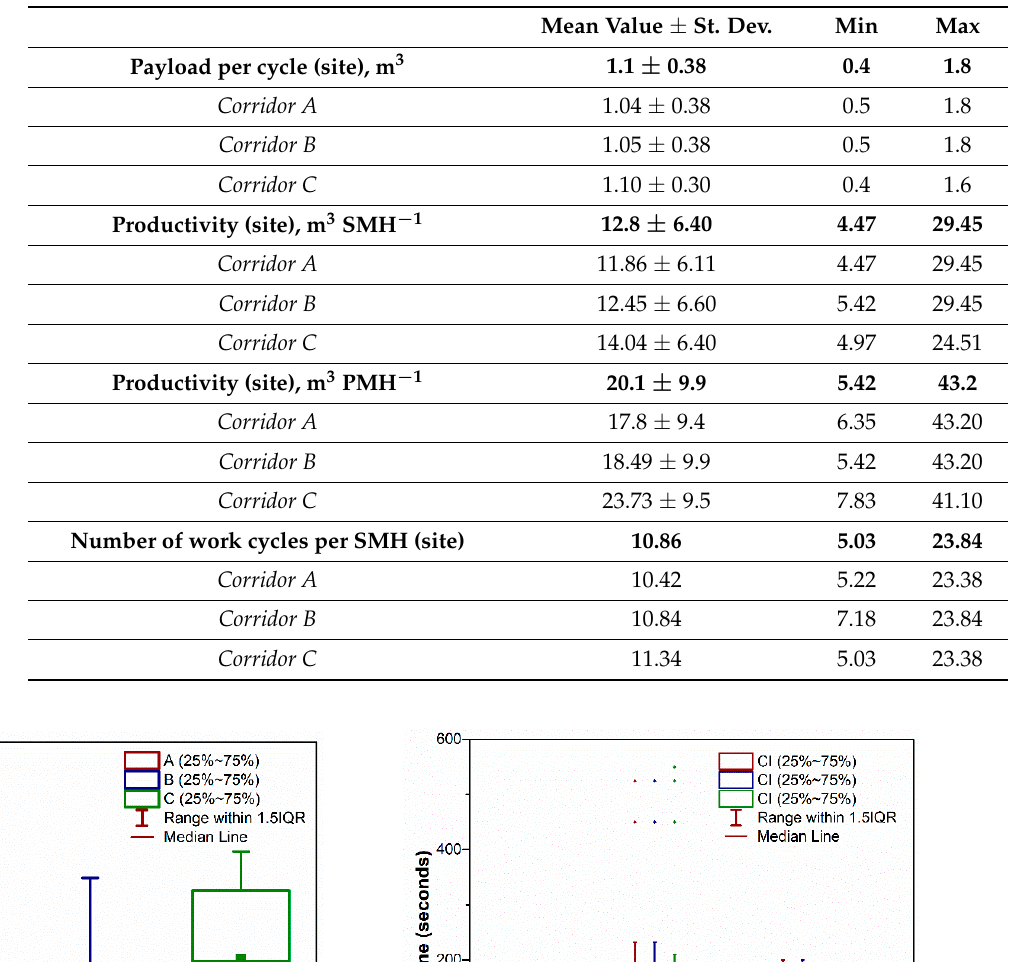
Table 4. Payload and productivity metrics. Mean Value ± St. dev.